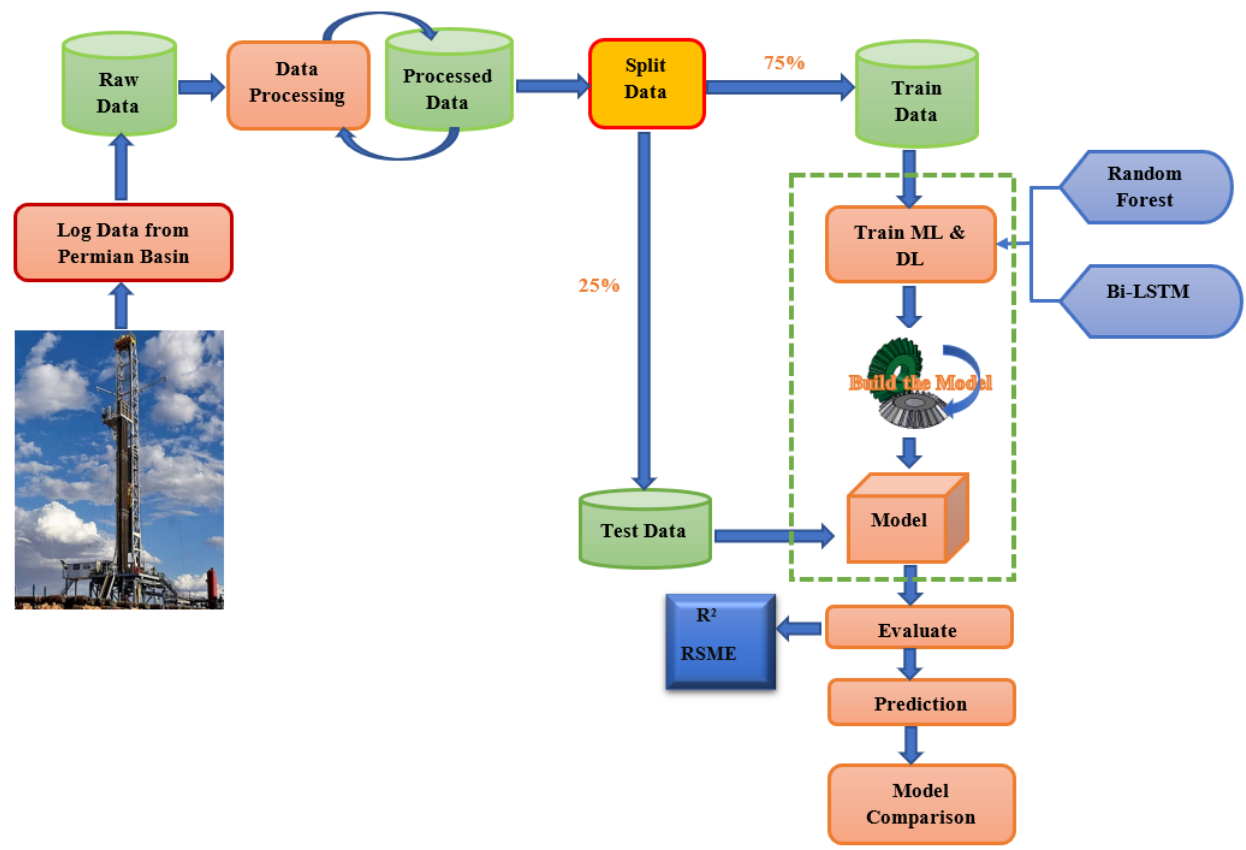
Figure 2. Workflow for estimating geomechanical properties.